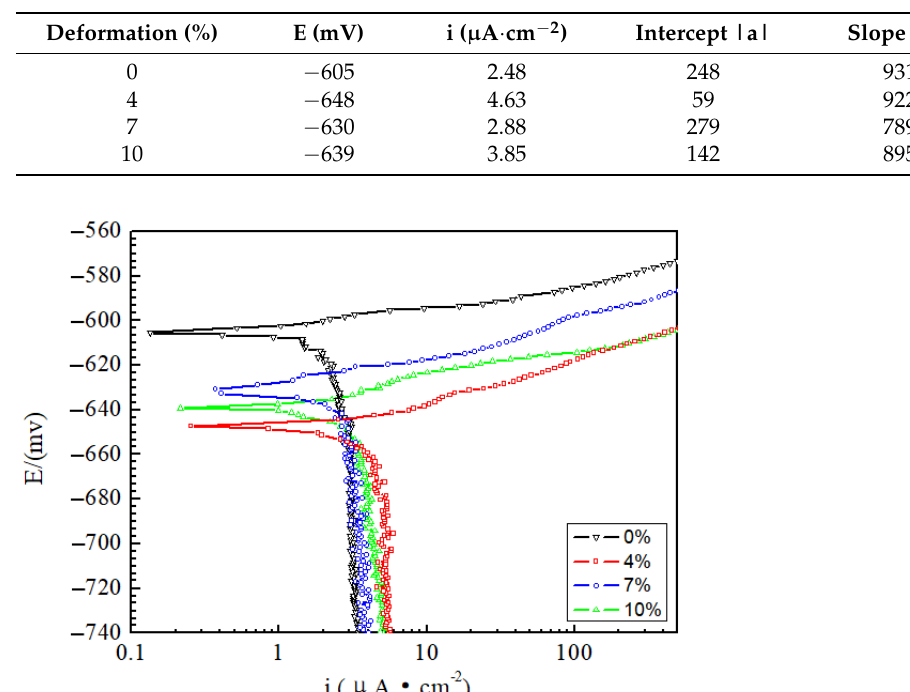
Figure 3. Tafel polarization curves of the 2024 FSWed joints with different deformations (0%, 4%, 7%, and 10%) in the 3.5% NaCl electrolyte. Table 2. Data extracted from the Tafel polarization curves in Figure 3.